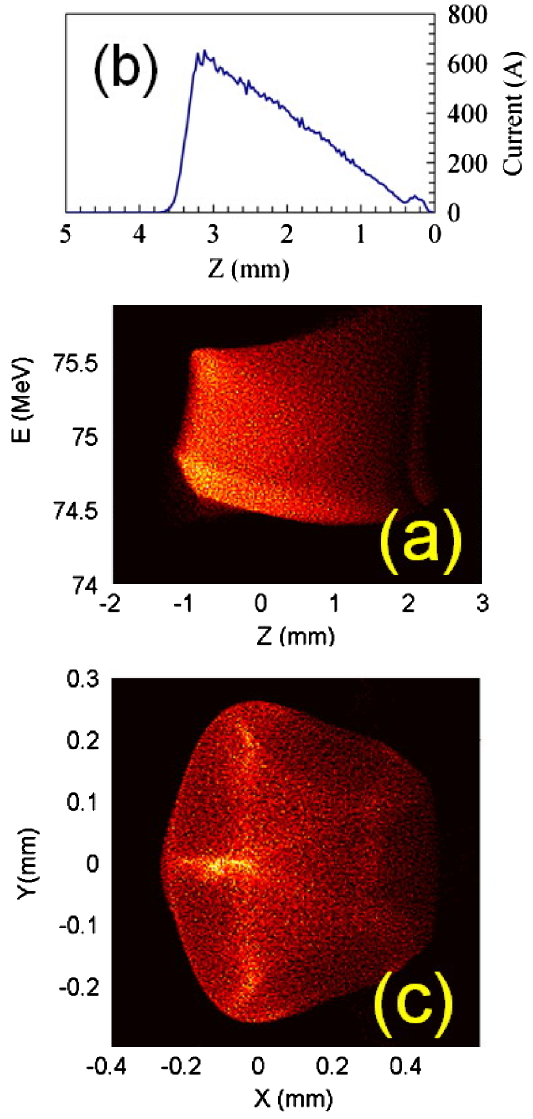
FIG. 5. (a) The simulated longitudinal phase space of the beam at the exit of EEX beam line; (b) beam current profile; (c) transverse size after a quads